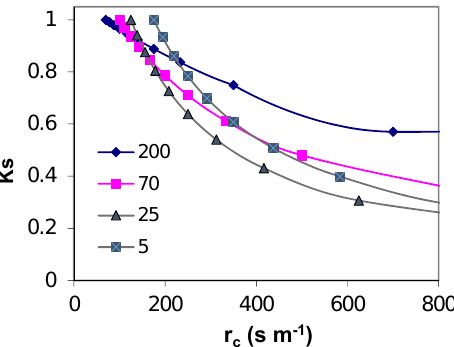
Figure 1. Simulation from Penman-Monteith equation ignoring interaction between variables illustrating how the stress coefficient (Ks) is expected to be lower for plants with high aerodynamic resistance (200 s m − 1 ), than for plants with low aerodynamic resistance (5 s m − 1 ) when stomata close and crop resistance (1/g s ) increases. The selected starting point for r c correspond to averages [56], in the range found for the stands with the specified r a .